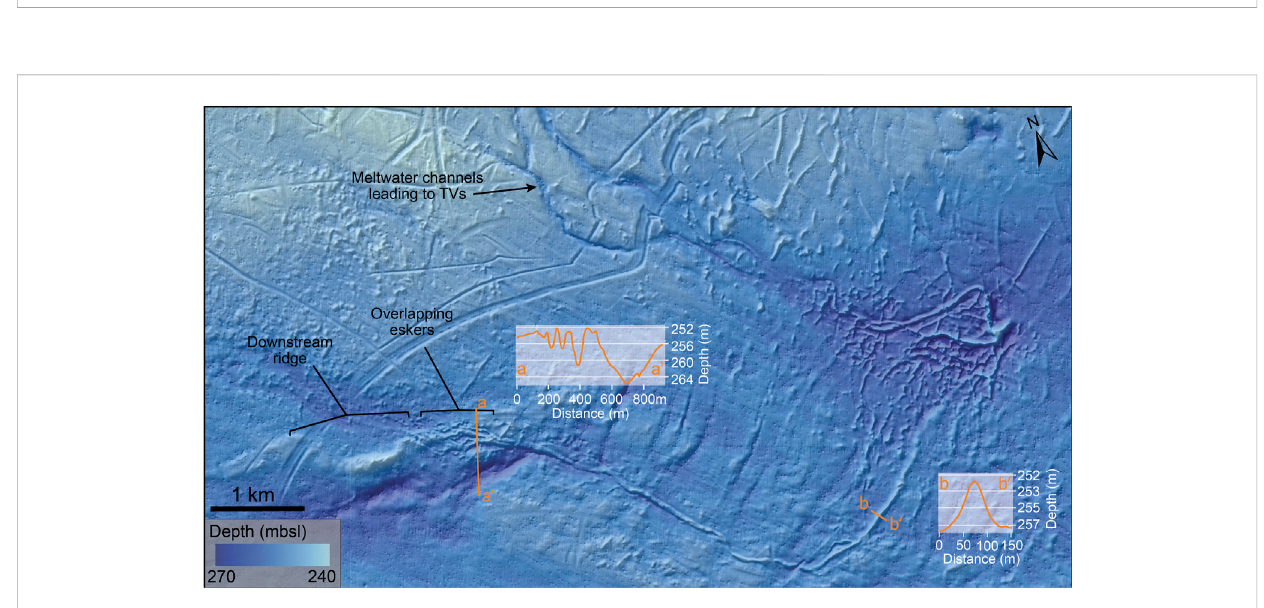
FIGURE 4 Site 2: Shaded relief map and pro fi les (a-a ’ , b-b ’ ) of complex esker ridges on northern Thor Iversen-banken.